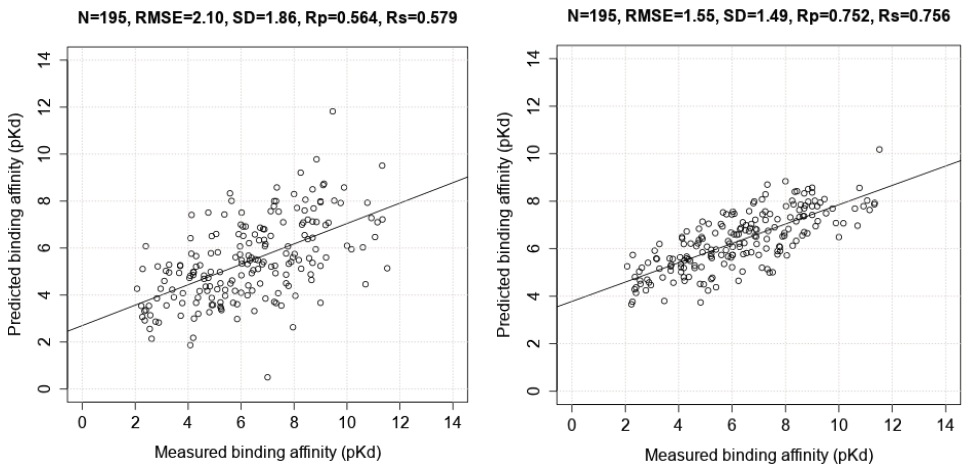
Figure 4. Correlation plots of measured and predicted binding affinity by AutoDock Vina ( Left ) and RF::VinaElem ( Right ) trained on PDBbind v2013 refined set minus v2013 core set ( n = 2764) tested on v2013 core set ( n =